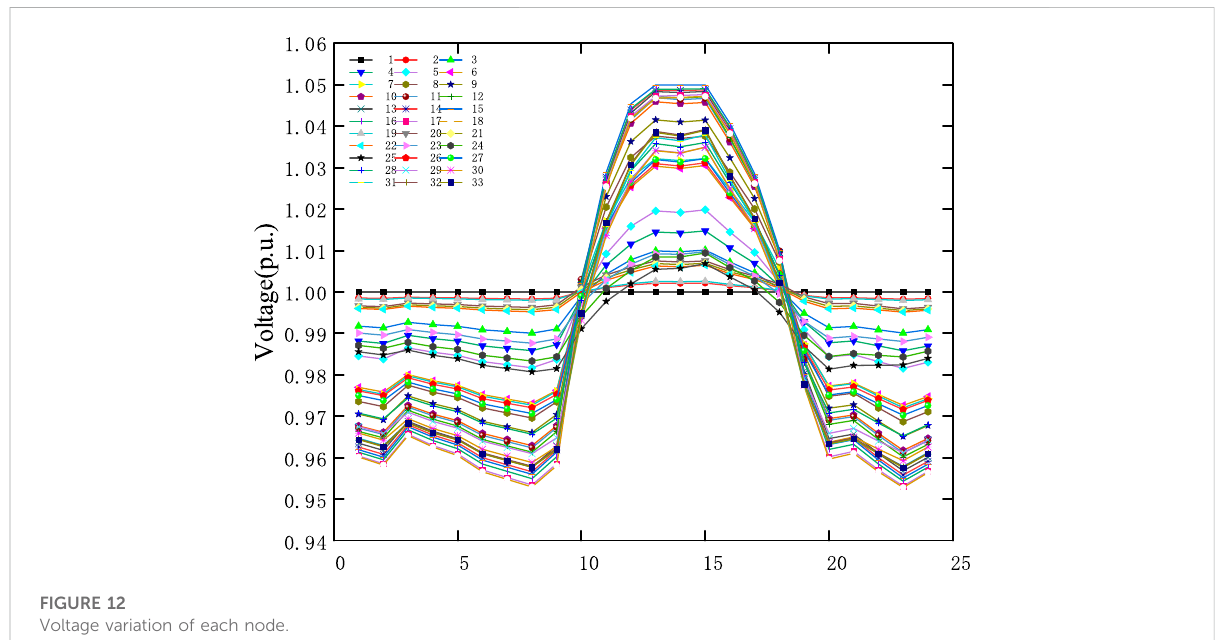
FIGURE 12 Voltage variation of each